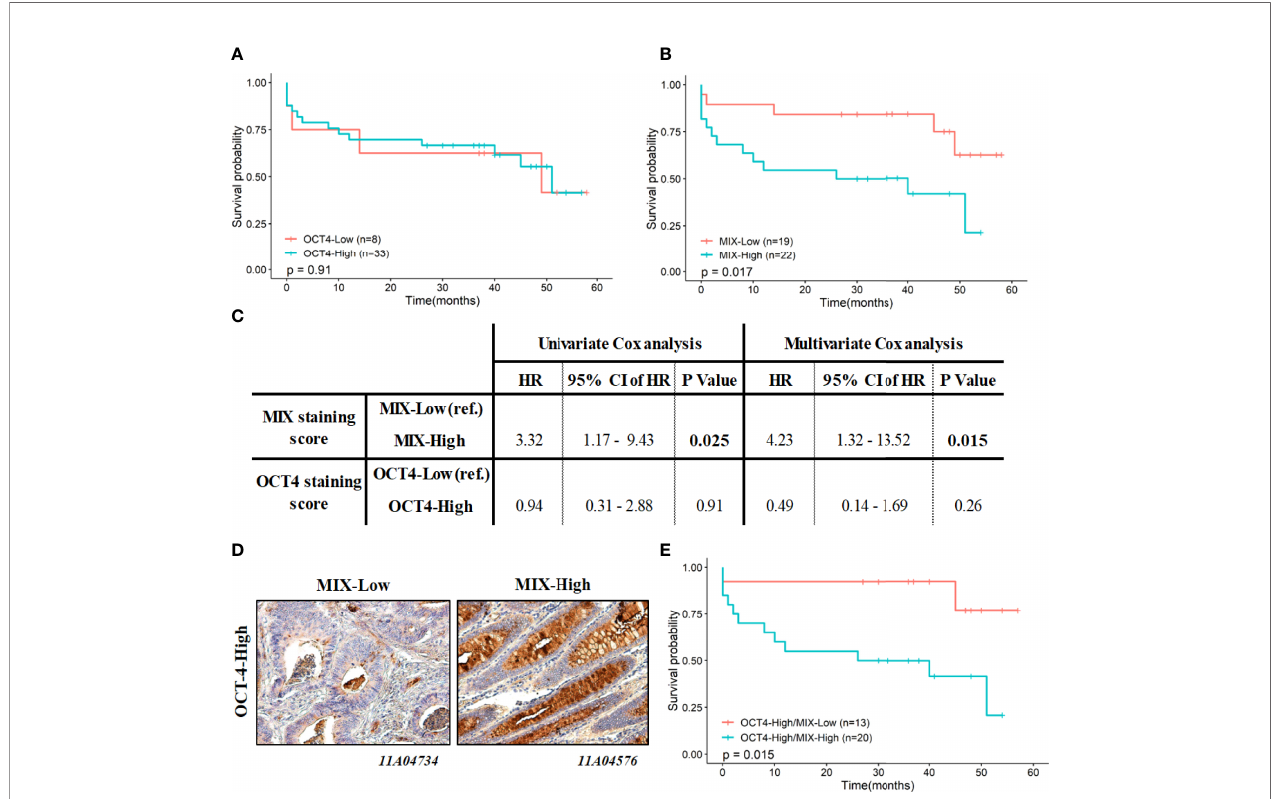
FIGURE 2 | Association between MIX and OCT-4 scoring with survival rates at 5 years (60 months). Kaplan-Meier curves at 5-years are depicted according to OCT-4-Low versus -High staining (A) , MIX-Low versus -High staining (B) and MIX-High/OCT-4-High versus MIX-Low/OCT-4-High co-staining (E) . P values indicated in each panel are related to the log-rank tests (Mantel-Cox) performed to survival curves comparison. (C) Prognostic value of MIX and OCT-4 scoring independently, was estimated using univariate and multivariate Cox regression models, and expressed with their HR and 95% CI. (D) Representative illustrations of MIX (brown) and OCT-4 (red/pink) staining, as observed by IHC, are depicted (magni fi cation, 200x) . CI: Con fi dence Interval; HR: Hazard ratio; IHC: